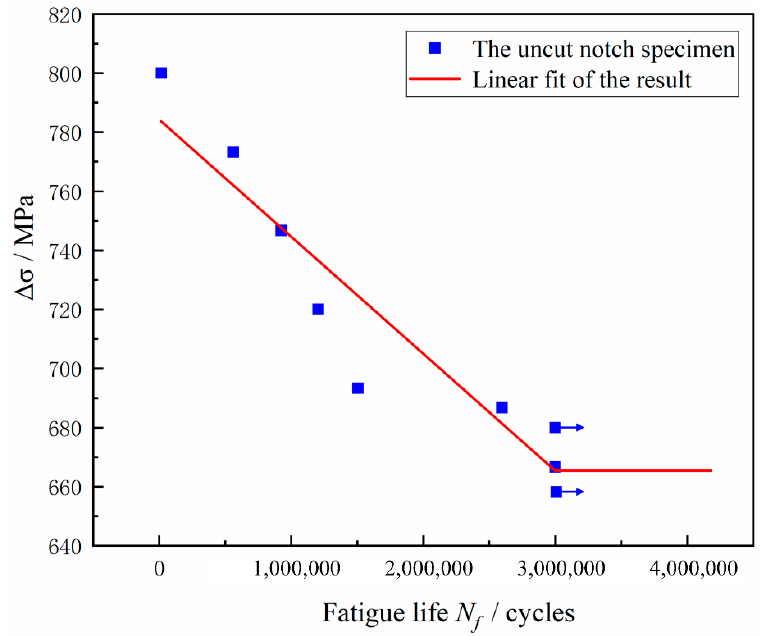
Figure 8. S-N curves of the 20Cr2Ni4 steel samples.